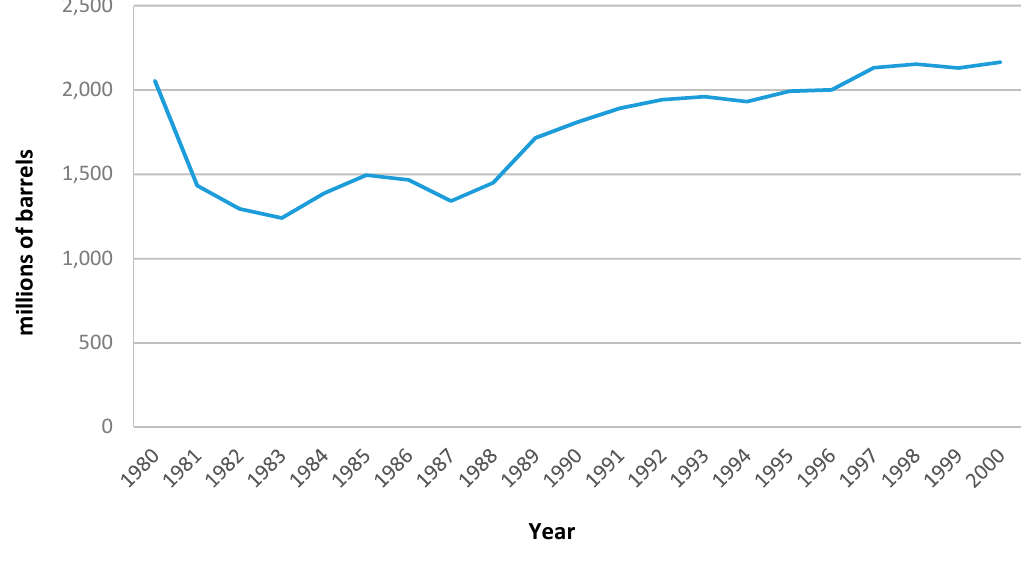
Figure 4. Nigeria’s crude oil production across 1980–2000 [32].